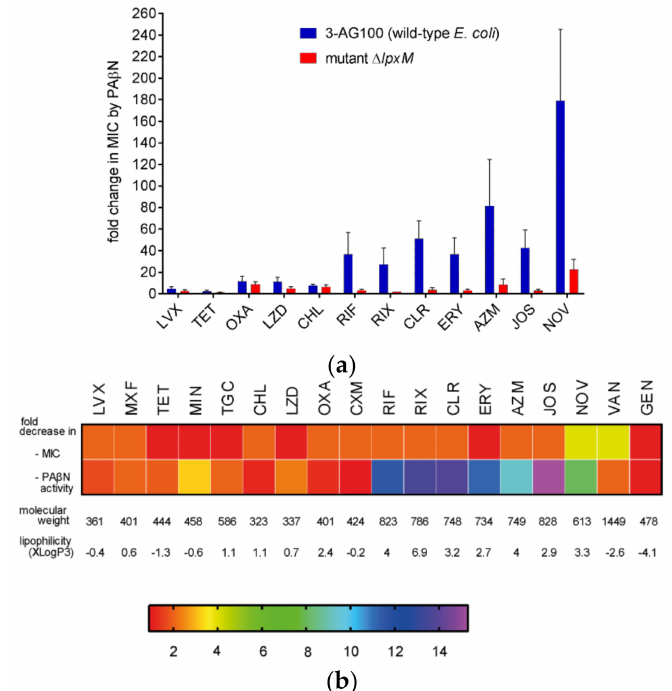
Figure 2. PA β N activity in mutant ∆ lpxM in comparison to its parent 3-AG100. ( a ) Ratios of MICs without and with 25 mg/L of PA β N; Statistical significance ( ∆ lpxM mutant vs. parent 3-AG100), p -values < 0.0001 for RIF, RIX, CLR, ERY, AZM, and NOV; other p -values < 0.01, except for LVX ( p -value 0.02), and for OXA and CHL ( p -value > 0.1; n ≥ 6). ( b ) Heat map depicting decreases in MIC (MIC 3-AG100 /MIC ∆ lpxM ) and in PA β N activity ((MIC 3-AG100 /MIC 3-AG100+PA β N )/(MIC ∆ lpxM /MIC ∆ lpxM+PA β N )), color scale of the heat map represents x-fold changes; molecular weights and computed partition coefficients XlogP3 of drugs from PubChem [27]. LVX, levofloxacin; MXF moxifloxacin; TET, tetracycline; MIN, minocycline; TGC, tigecycline; CHL, chloramphenicol; LZD, linezolid; OXA, oxacillin; CXM, cefuroxime; RIF, rifampin; RIX, rifaximin; CLR, clarithromycin; ERY, erythromycin; AZM, azithromycin; JOS, josamycin; NOV, novobiocin; VAN, vancomycin; GEN, gentamicin. MICs are provided in Tables S1 and